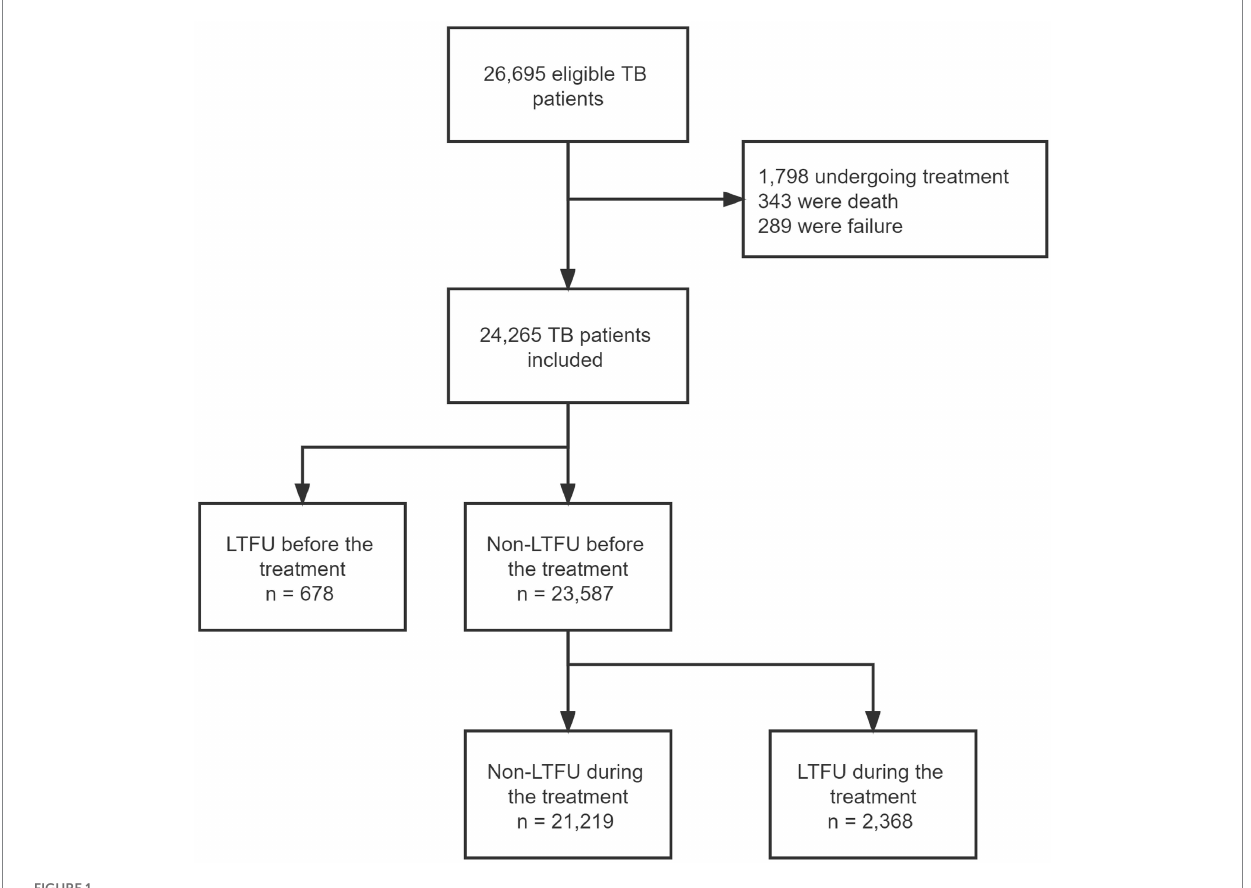
FIGURE 1 Flow diagram of the